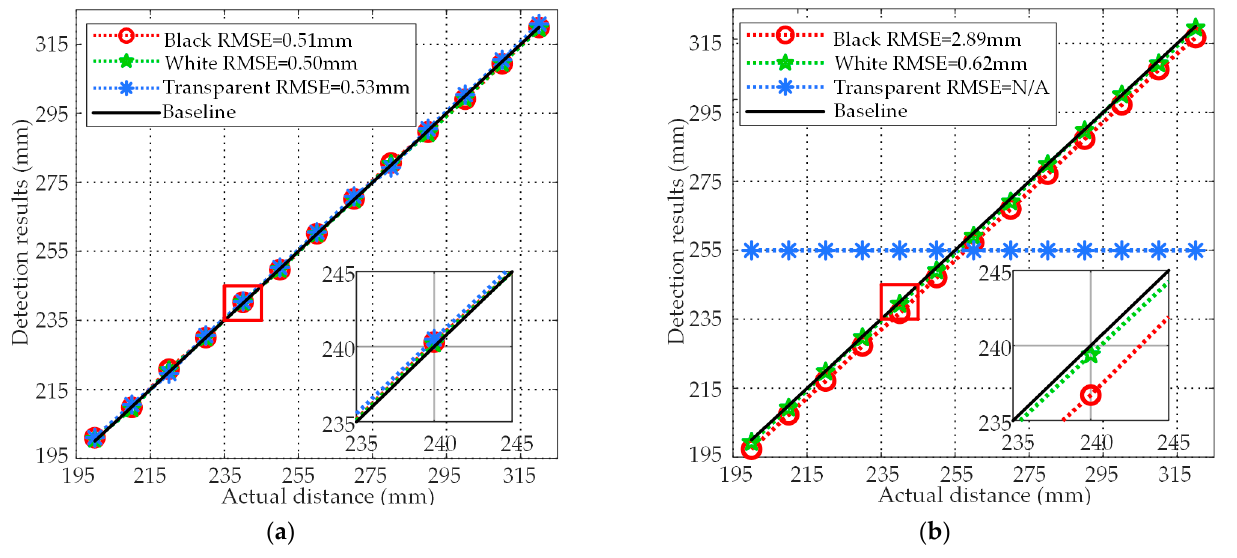
Figure 9. ( a ) Results of the PMUTs-based ultrasonic sensor and ( b ) the laser sensor in the static Figure 9. ( a )ResultsofthePMUTs-basedultrasonicsensorand( b experiments. Table 2. Reflectivity and Transmittance of Ultrasonic and Light Waves.